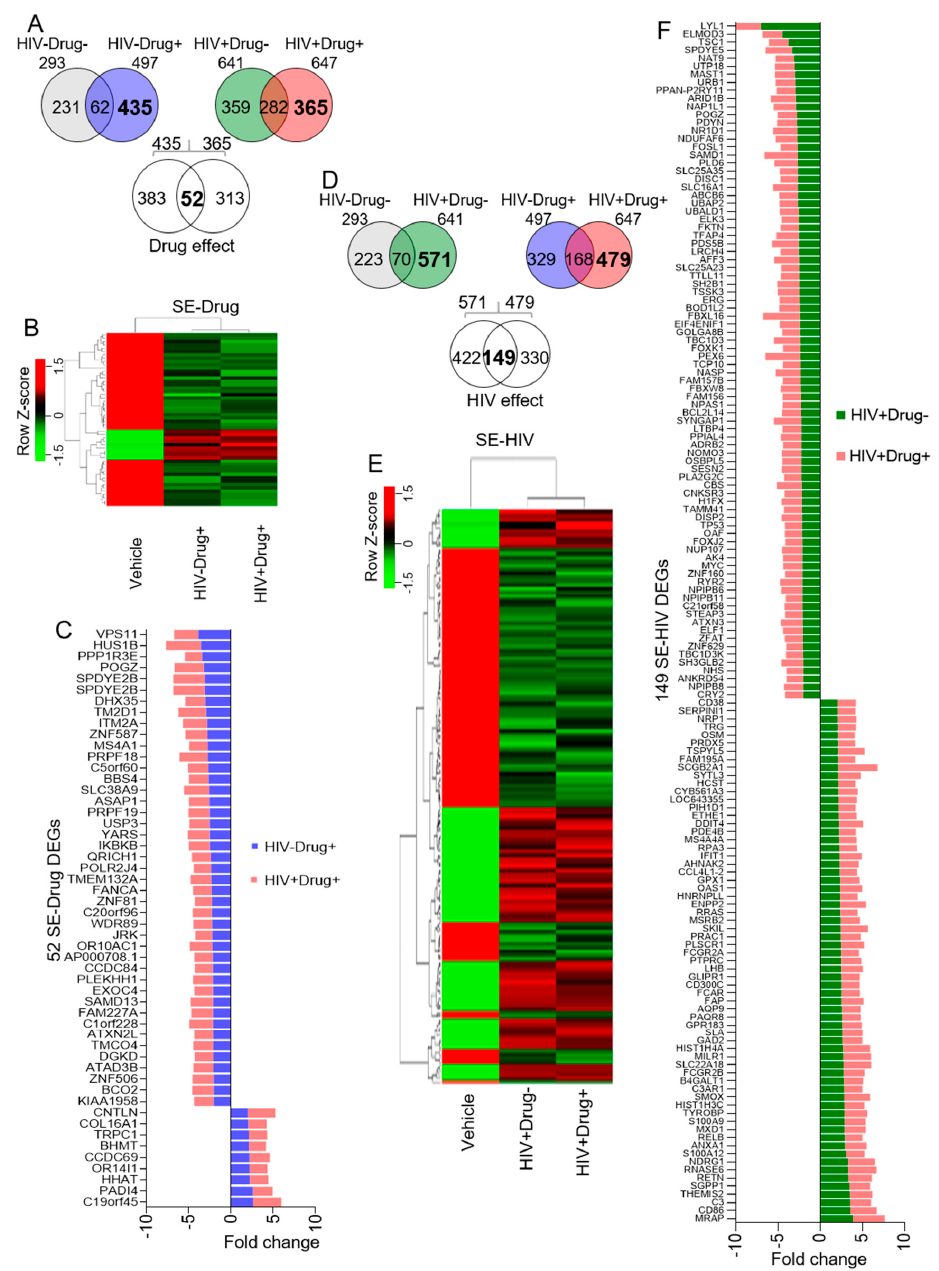
Figure 3. Microarray analysis of SE-treated monocytes showing the effect of psychostimulant use and HIV infection on SE function: ( A ) Venn diagram showing 52 DEGs exclusive to the alterations induced by treatment with HIV − Drug + and HIV + Drug + SE (SE-Drug). ( B ) Hierarchical clustering heatmap showing the overall and direction of expression of the 52 SE-Drug. ( C ) Bar graph showing the fold change of the 52 SE-DEGs as compared to vehicle. ( D – F ) Similar analyses as in Figure 3A–C showing 149 HIV exclusive DEGs in cells treated with HIV+Drug − and HIV+Drug+ SE (SE-HIV). The bold fonts in the Venn diagrams are the numbers of interest.